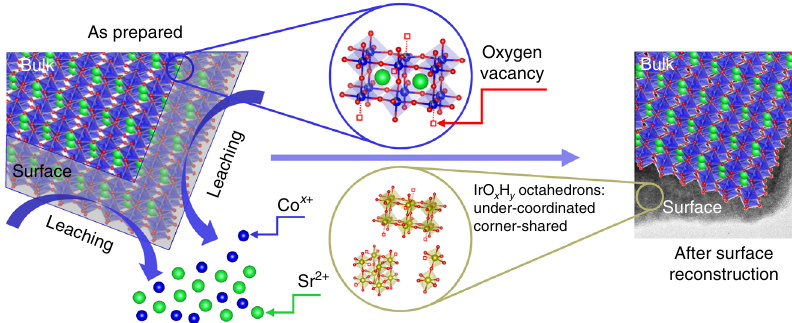
Fig. 4 Surface reconstruction. A schematic that illustrates the surface reconstruction over the SrCo 0.9 Ir 0.1 O 3 − δ